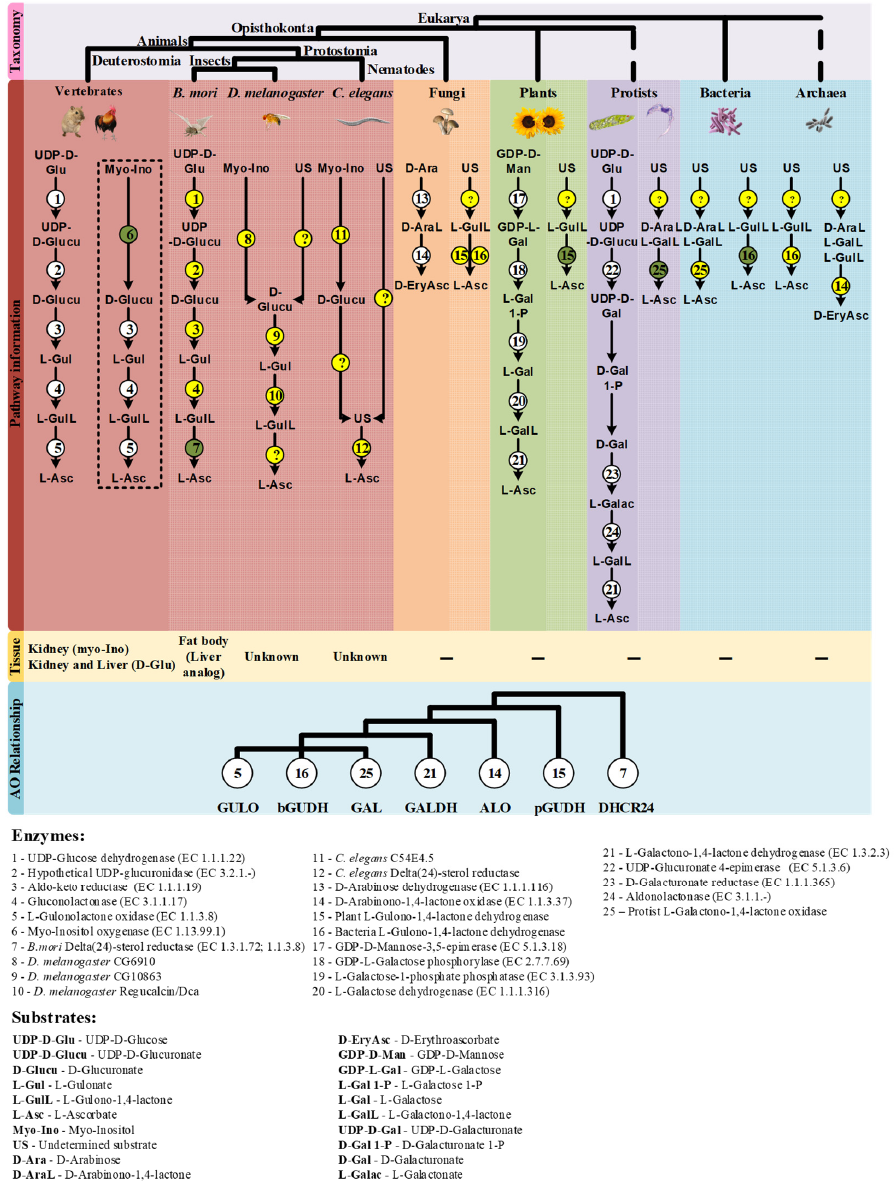
Figure 6. Summary of the findings discussed in this review. The taxonomic relationship between the species mentioned in this work is displayed on the top of the figure. The characterized VC synthesis pathways and the putative alternatives in eukaryote and prokaryote species are presented in the mid part of the figure. The pathways already described in the literature are highlighted with bold colors according to the taxonomic groups mentioned, while the putative VC pathways are presented in the gridline sections. The enzymes that intervene in the substrate conversions are presented by numbered circles according to the following scheme: Circles in white represent enzymatic reactions described in the literature, circles in yellow represent hypothetical enzymatic reactions and circles in green indicate novel enzymatic constituents of putative alternative VC synthesis pathways with available functional characterization. The question marks (?) represent putative enzymatic reactions for which no candidate enzyme can be suggested with current data. The tissues correlated with VC synthesis in animal species are represented below the corresponding proposed pathways when available. The dashed box highlights the myo-Inositol VC synthesis pathway that is exclusively used by species that synthesize VC in the kidney. The phylogenetic relationship inferred between the studied AOs is summarized in a cladogram format at the bottom. The enzyme number and substrate acronym lists are presented below the figure to facilitate the